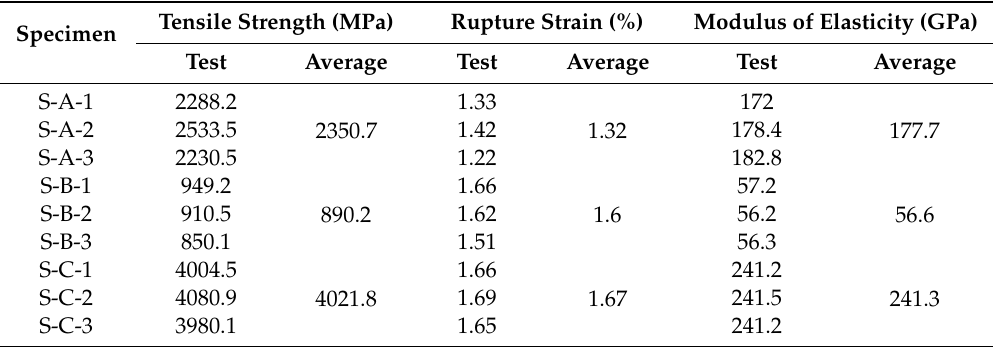
Table 2. Tensile test results of FRP flat